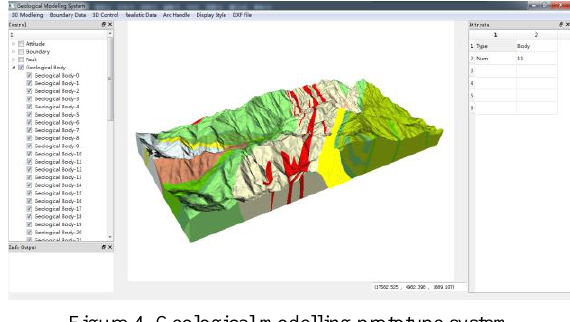
Figure 4. Geological modelling prototype system